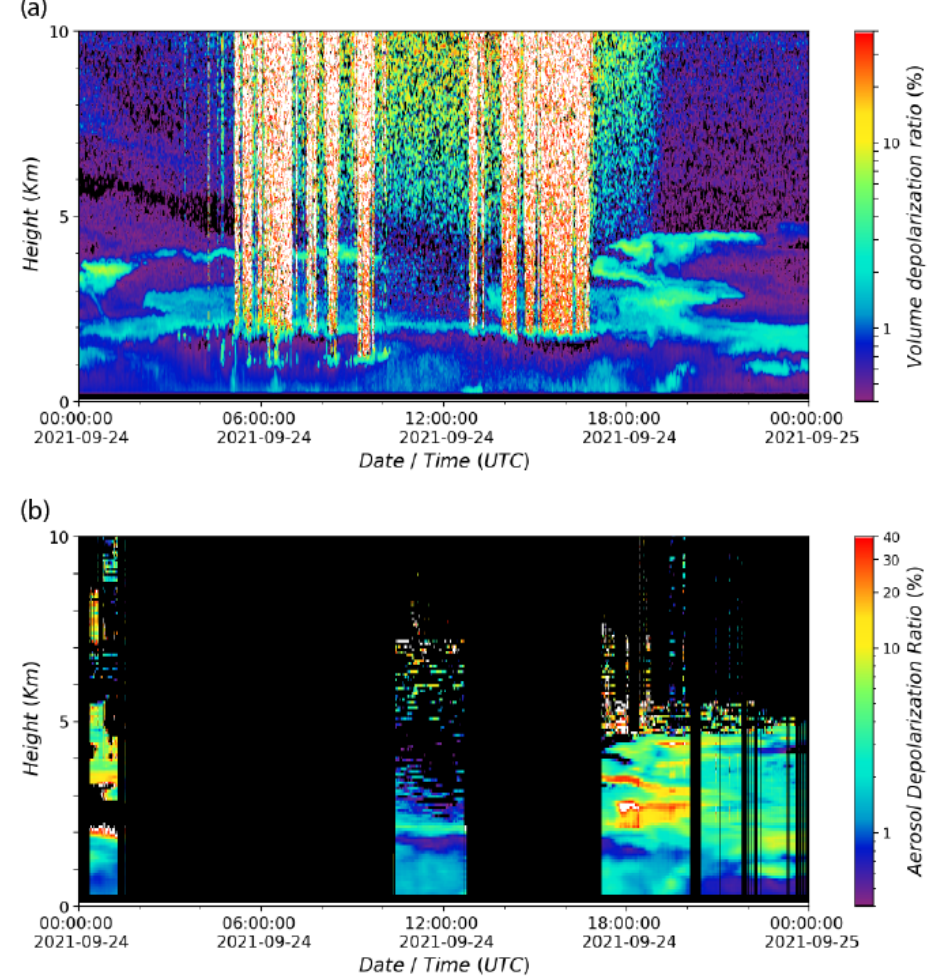
Figure A1. ( a ) Volume depolarization ratio ( δ vol ) and ( b ) aerosol depolarization ratio ( δ aer ) determined from the MPL at 532 nm at the SCO for 24